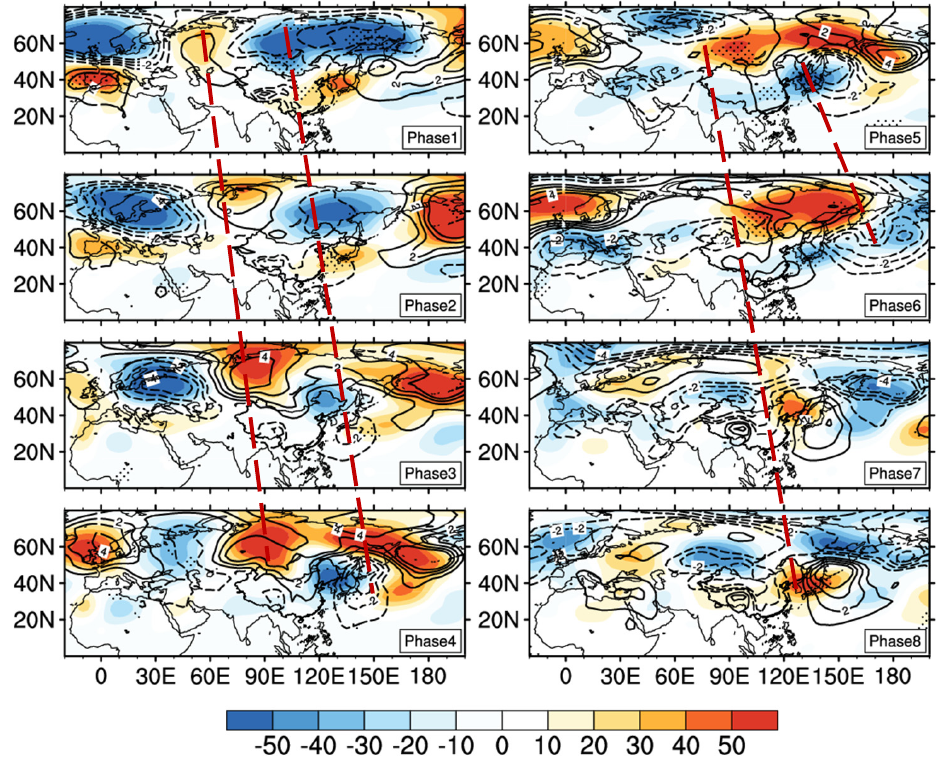
Figure 9. Temporal evolution of 10–30-d filtered 500-hPa geopotential height (shading, unit: gpm) and sea-level pressure (contours, unit: hPa) during six cold precipitation events. (Dotted areas are where height passed 95% significance test; the red line is the wave train shift.)